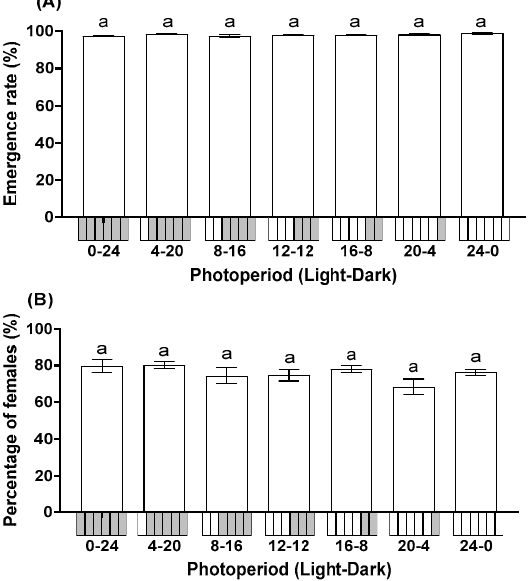
Figure 2. Influence of photoperiod on the emergence rate ( A ) and percentage of female progeny ( B ) of T. remus using S. litura eggs as the alternative host. Data are represented as mean ± SE. Different lowercase letters indicate significant differences among several photoperiods at α = 0.05 (Tukey test).